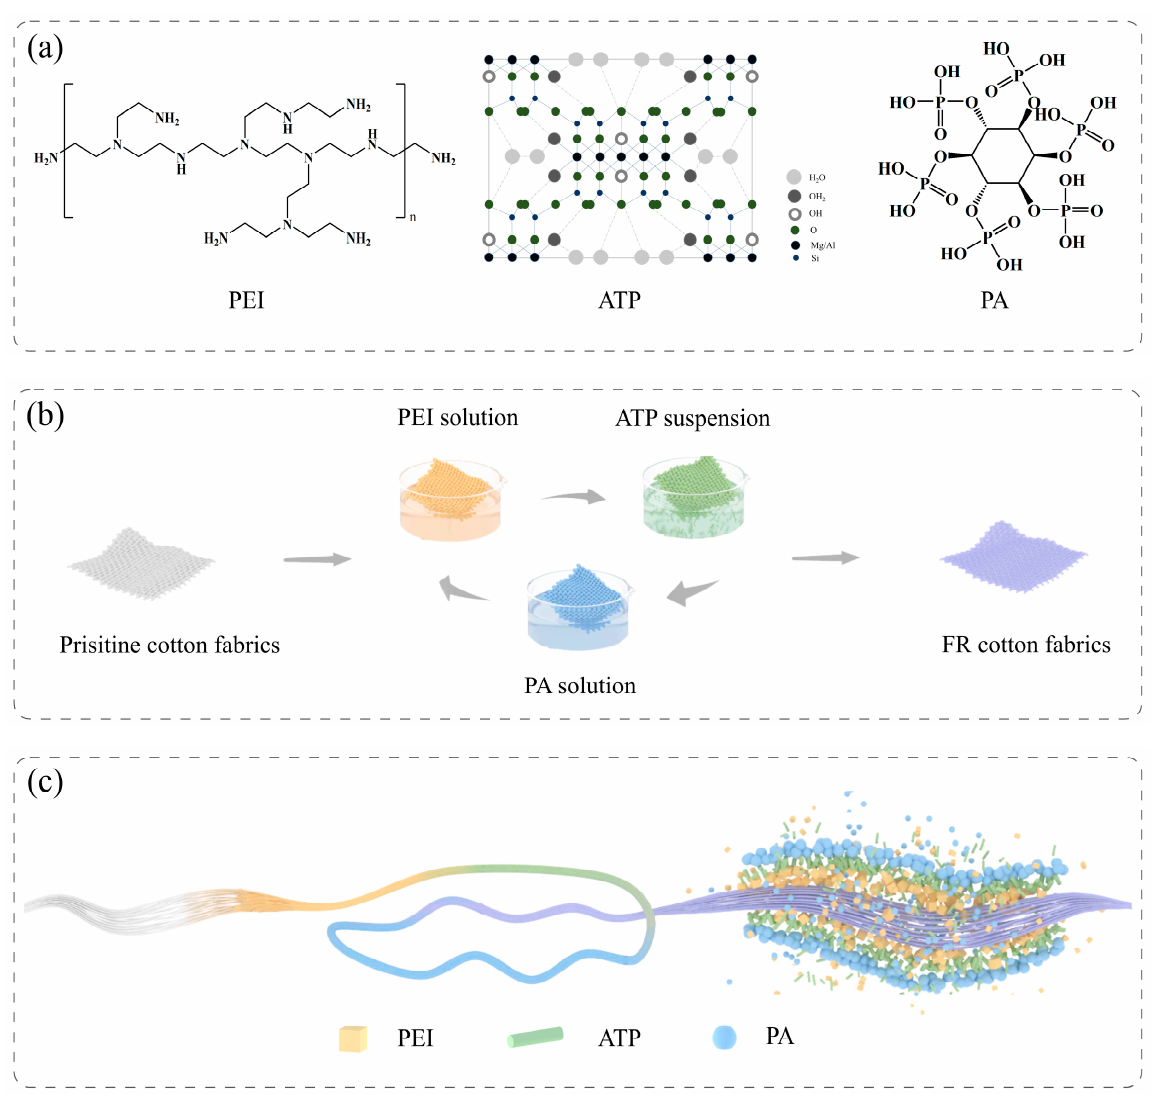
Figure 1. ( a ) Chemical structure of PEI and PA and the crystal structure of ATP, ( b ) diagrammatic illustration of LbL assembly process, and ( c ) the change of a single cotton fiber during the LbL treat ‐ ment.